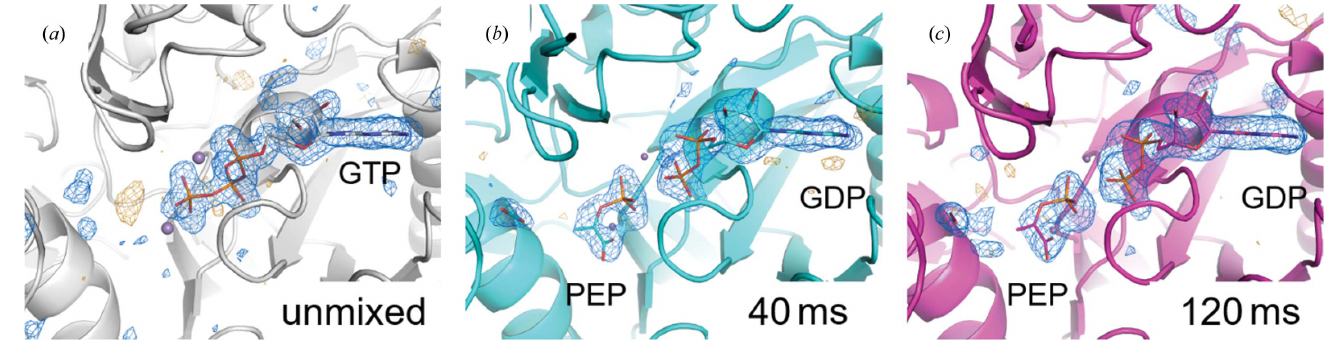
Figure 4 ( a ) Polder map of unmixed PEPCK (gray) data omitting GTP. ( b ) 40 ms time-point (cyan) Polder map omitting PEP, GDP and CO 2 . ( c ) 120 ms time- point (magenta) Polder map omitting PEP, GDP and CO 2 . All Polder maps are shown at 3.5